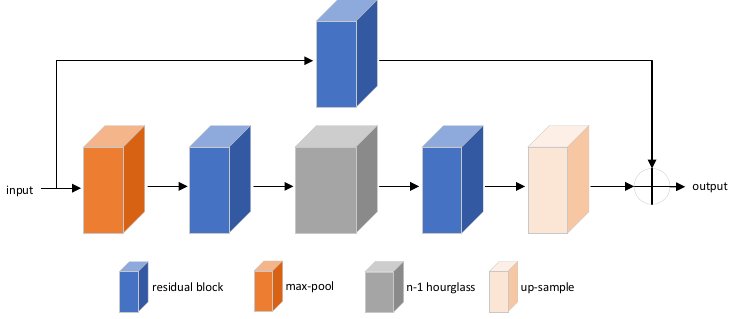
Figure 9. The detailed architecture of n-hourglass block. The n-hourglass block consists of residual, max-pooling, up-sampling, and n-1 hourglass